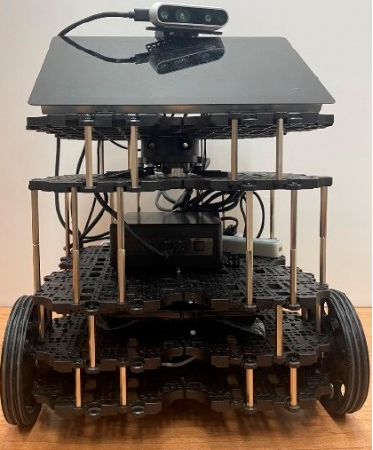
Figure 8. Human pose recognition system.